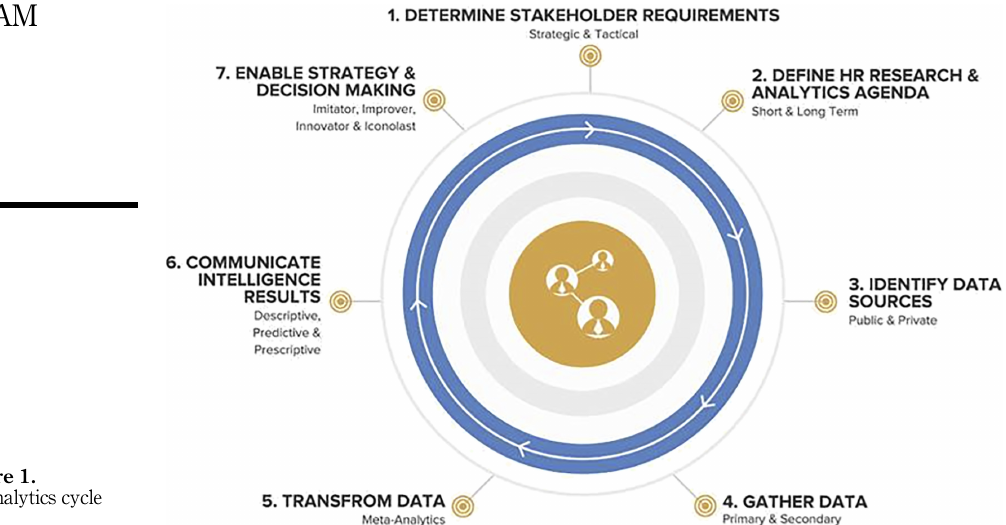
Figure 1. HR analytics